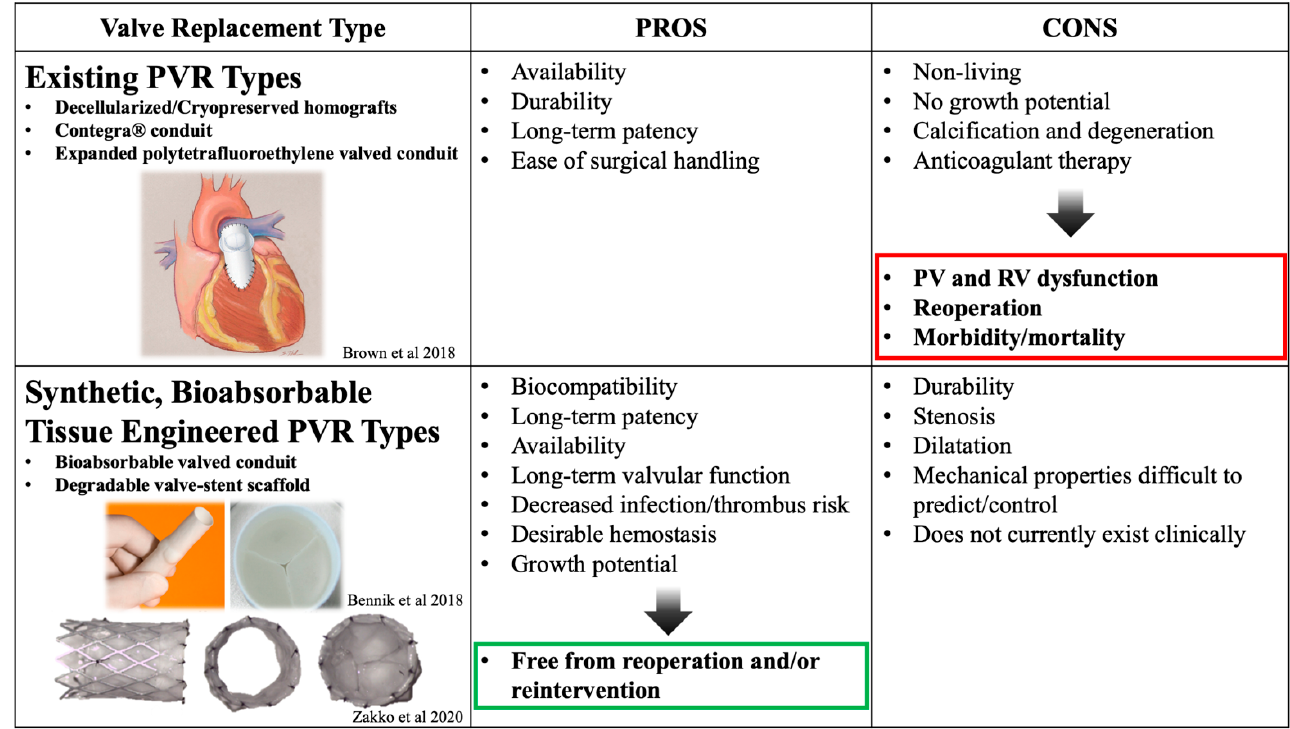
Figure 1. Pros and cons of current existing PVR options and a theoretical TEPV for PVR. The image in the top left is from an editorial on a PTFE RV-PA conduit [40]. The images in the bottom left box are of different views of the Xeltis biodegradable pulmonary valve conduit [41] from a bioabsorbable metal stent PVR from Zakko et al. 2020 [42]. PVR: Pulmonary valve replacement; PV: pulmonary valve; RV: Right ventricle; the green and red squares are to emphasize.